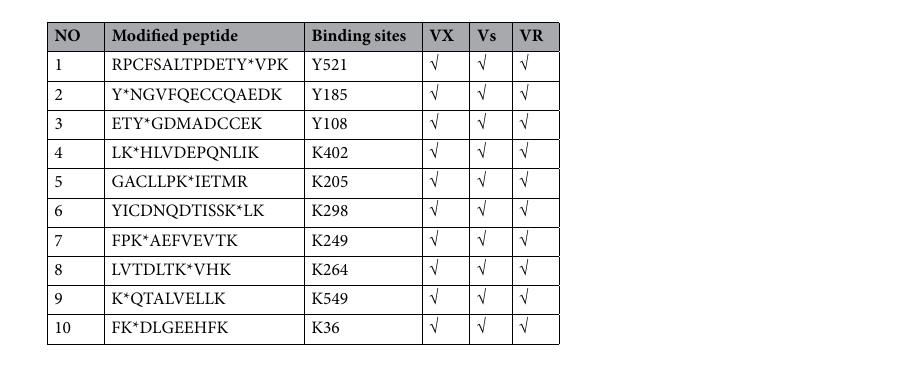
Table 1. Phosphonylated sites modified by V-type agents in bovine